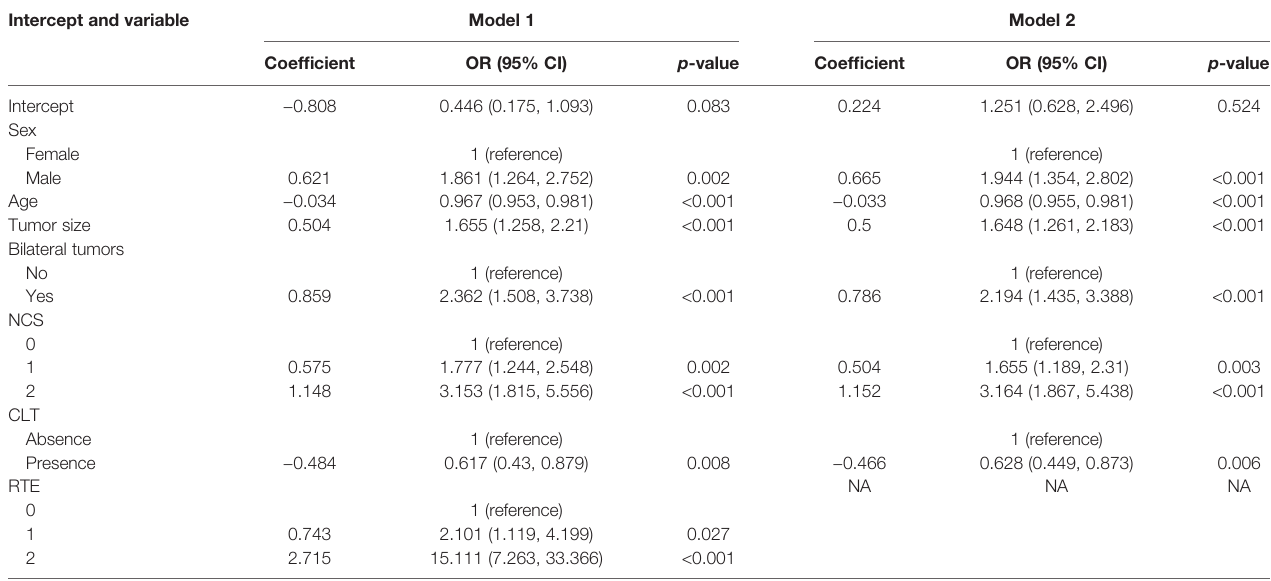
TABLE 2 | Risk factors and regression coef fi cient of prediction models.